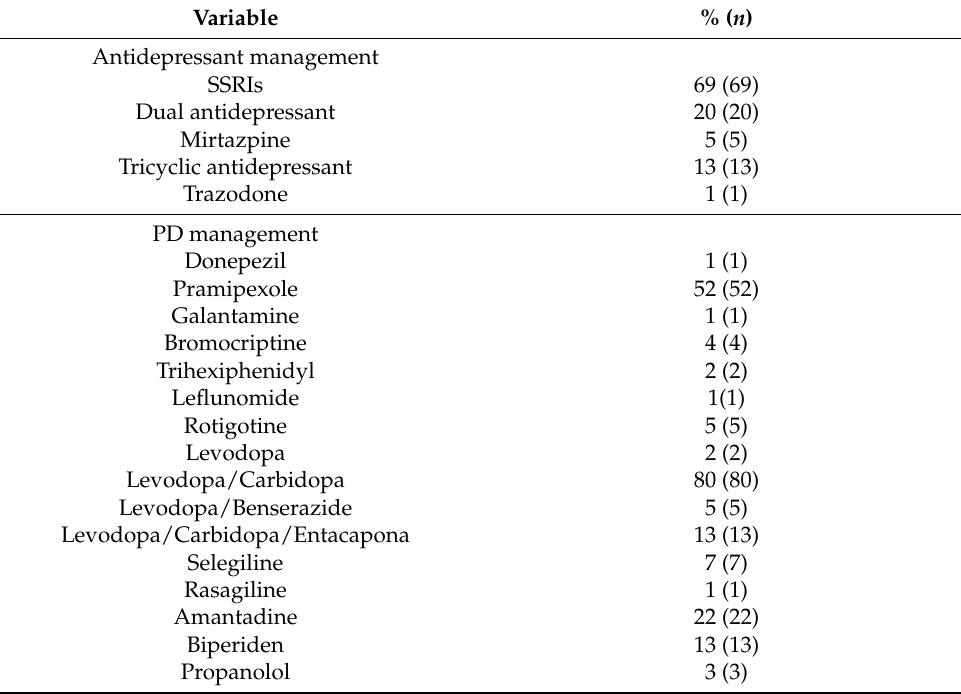
Table 2. Drug variables in the general sample ( n =